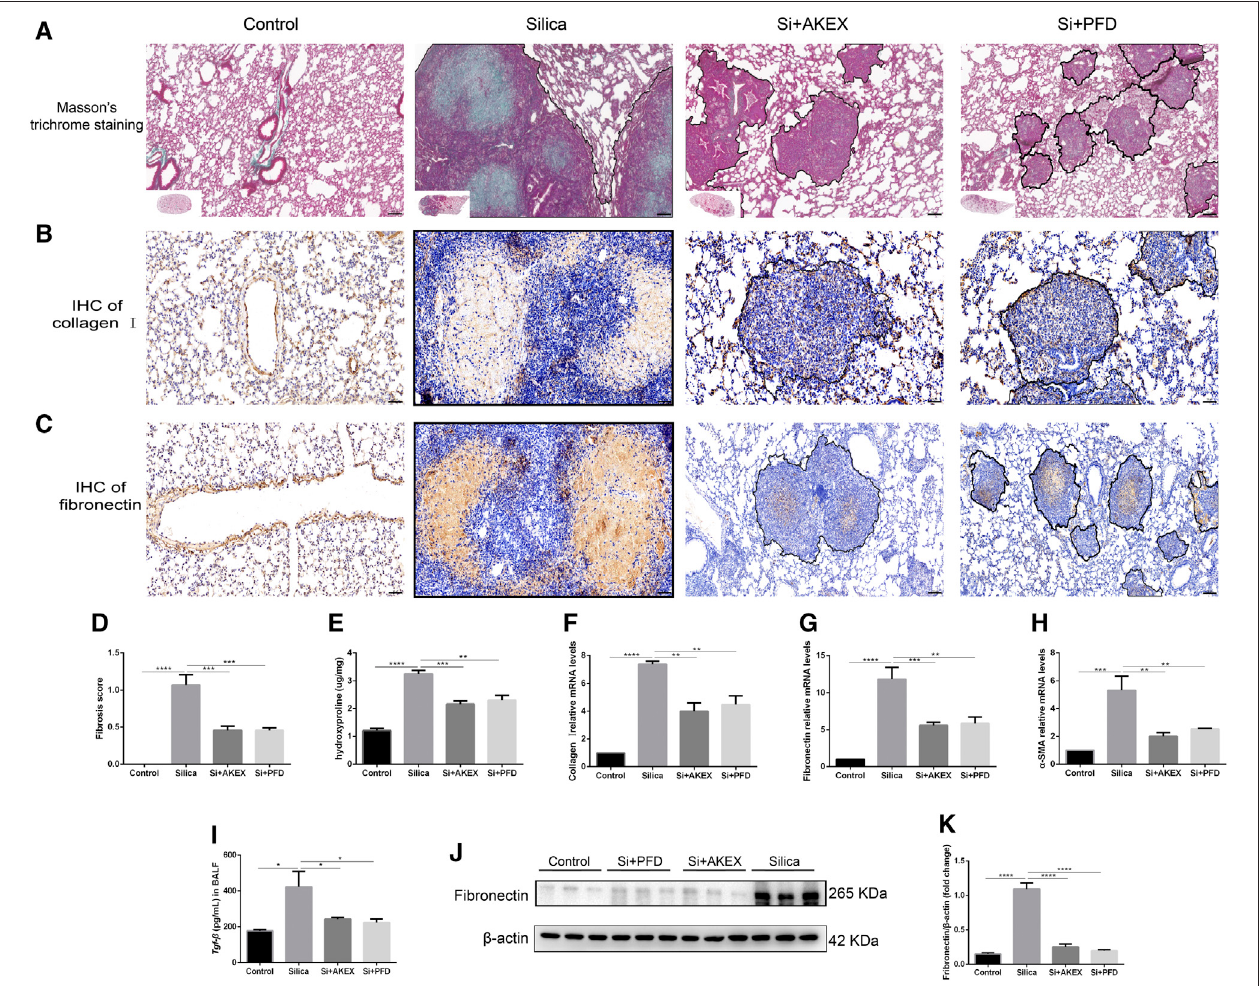
FIGURE6| AKEX0011reducedpulmonaryin fl ammationand fi brosisintheadvancedtherapeuticsilicosismodel. (A) Masson ’ strichromestainingonlungsections (original magni fi cation ×100). (B,C) IHC staining ofcollagen Iand fi bronectin on lung sections (original magni fi cation ×100) (n =3). (D) fi brosisscore (based on Masson ’